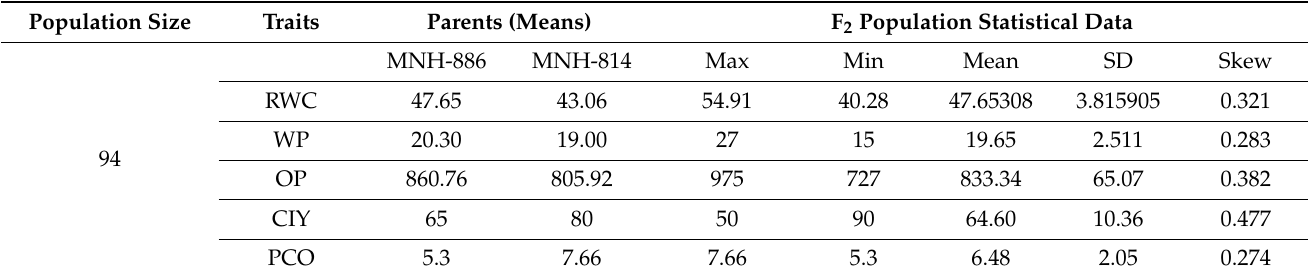
Table 4. Stress determining physiological traits (Relative Water Content = RWC, water potential = WP,